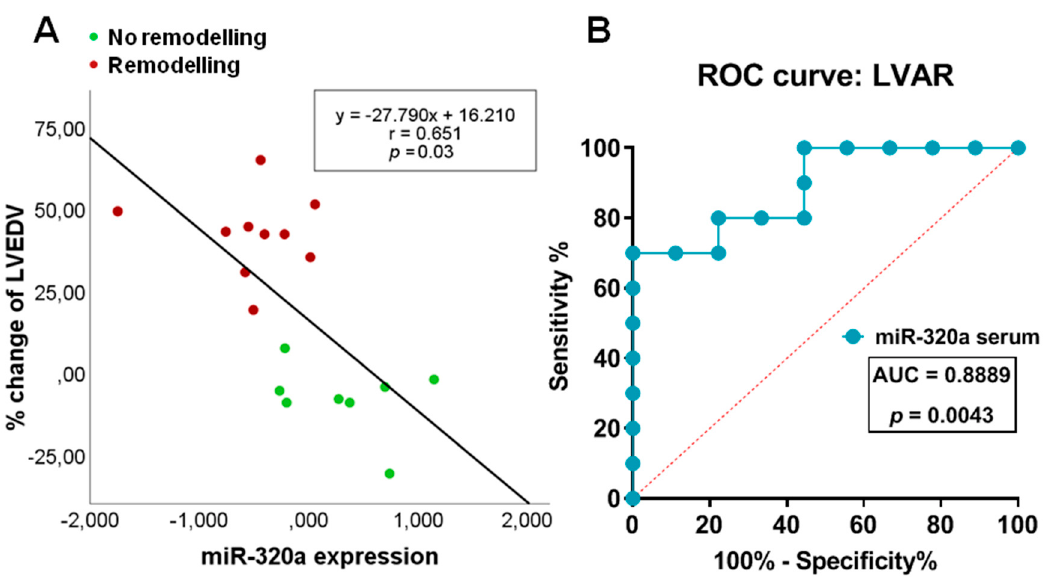
Figure 6. Correlation of serum levels of miR-320a with left ventricular adverse remodelling (LVAR) and receiver-operating characteristics (ROC) analysis. ( A ) Linear regression analysis using the percentage of change in left ventricular end-diastolic volume (LVEDV) as dependent variable and miR-320a expression 1 month post-PPCI as independent. ( B ) The area under the curve (AUC, values given on the graphs) analysis of ROC indicating sensitivity and specificity of miR-320a in predicting LVAR. Table 3. Multivariate logistic regression to determinate independent predictors of LVAR. OR: odds ratio; CI: confidence interval. (*) indicates p < 0.05, which is considered statistically significant; & miR-320a expression in patients’ serum at 1 month post-PPCI.